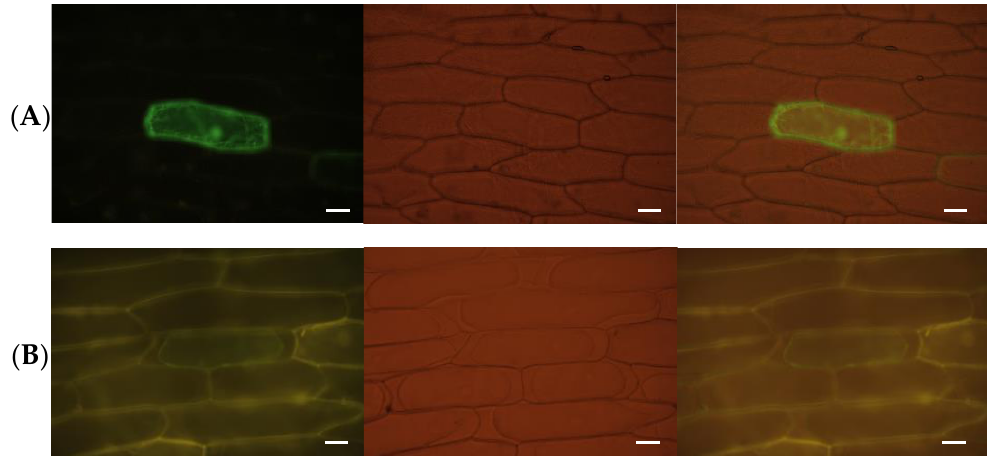
Figure 3. Subcellular localization of the TaABCG36-GFP fusion protein. ( A ) The control GFP protein. ( B ) The TaABCG36-GFP fusion protein. Scale bars are 50 µm.